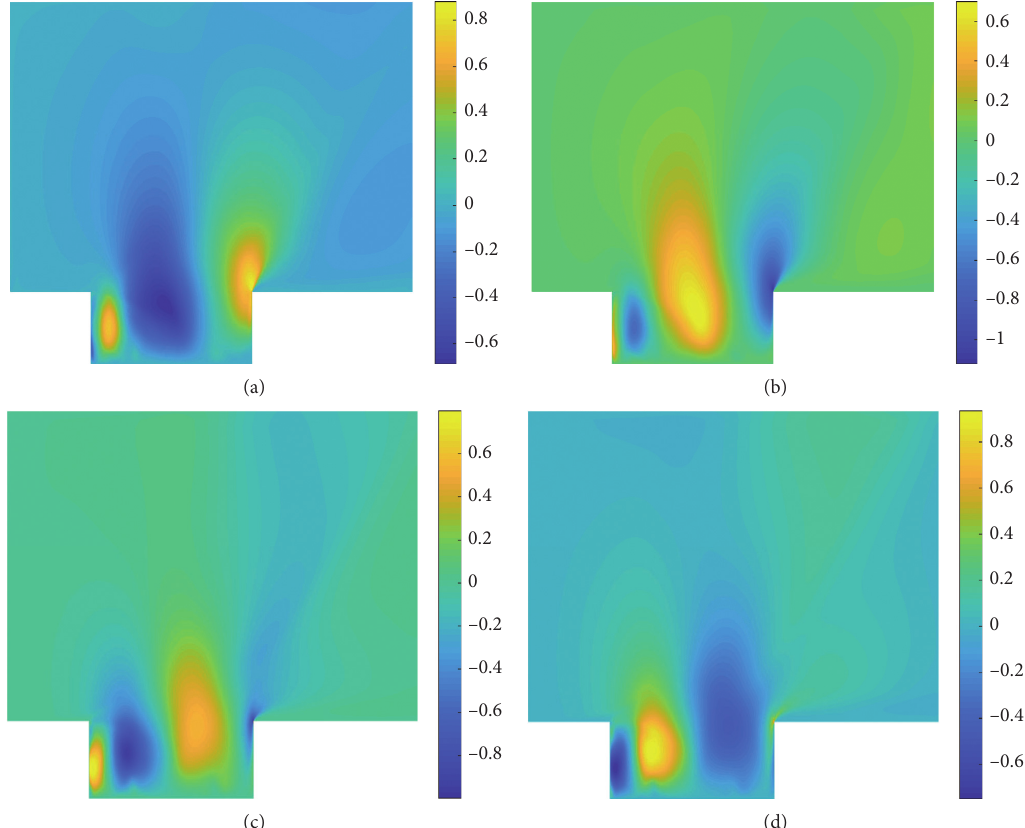
Figure 7: The first two POD modes at Ma � 0.51 and Ma � 0.6. (a) Mode 1 at Ma � 0.51. (b) Mode 2 at Ma � 0.51. (c) Mode 1 at Ma � 0.6. (d) Mode 2 at Ma �